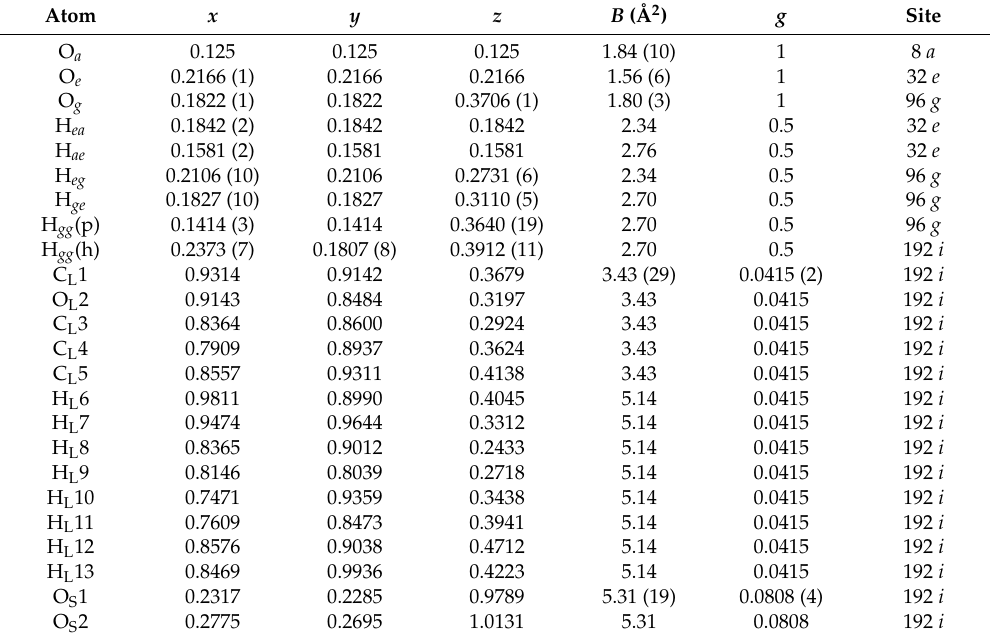
Table 1. Atomic coordinates and isotropic temperature factors for binary tetrahydrofuran (THF) + O 2 hydrate at 100 K. H ea : hydrogen covalently connected with O e and hydrogen bonded with O a (O e -H ea · O a ). H gg (p): hydrogen in pentagonal ring; and H gg (h): in hexagonal ring. Site: multiplicity and Wyckoff